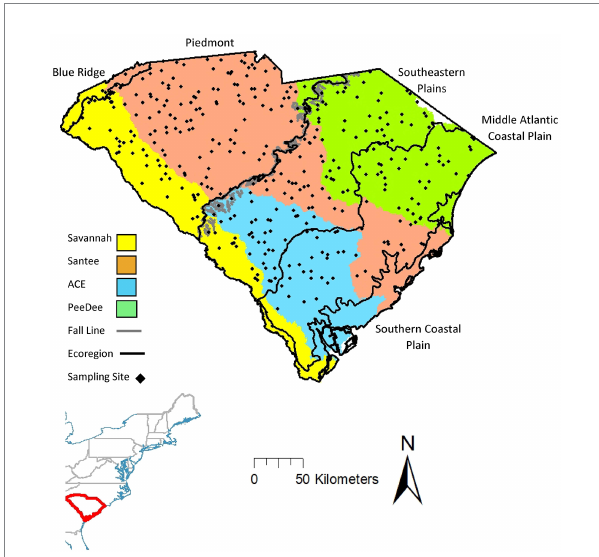
FIGURE 1 South Carolina, USA with sampling site locations and watershed color delineations used in analysis. The fall line crosses through the middle of the state and divides streams into two distinct types: with the upstate to the northwest and lowland to the